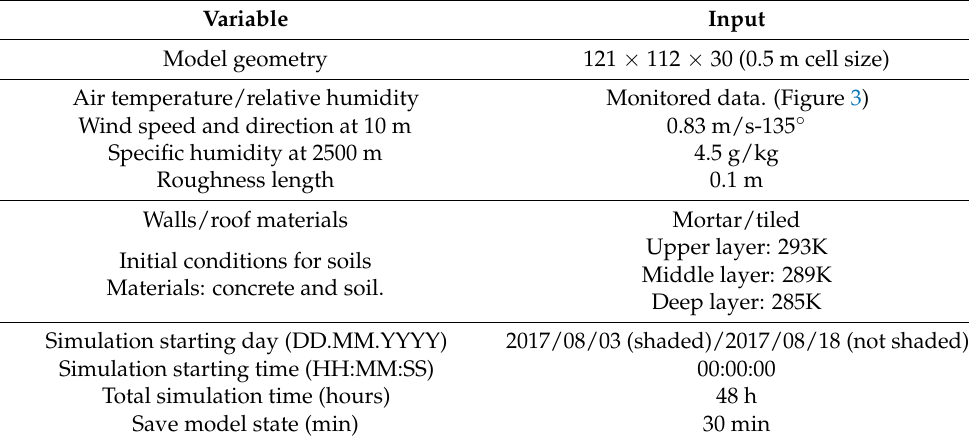
Table 2. Input variables for the ENVI-met